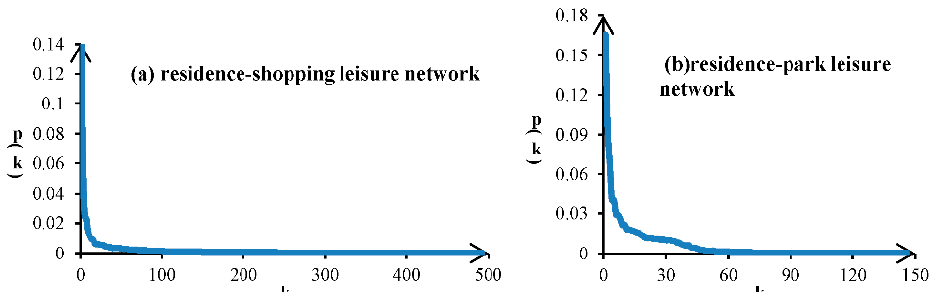
Figure 2. Probability distribution characteristics of the node degree of residence–leisure network for different travel purposes.